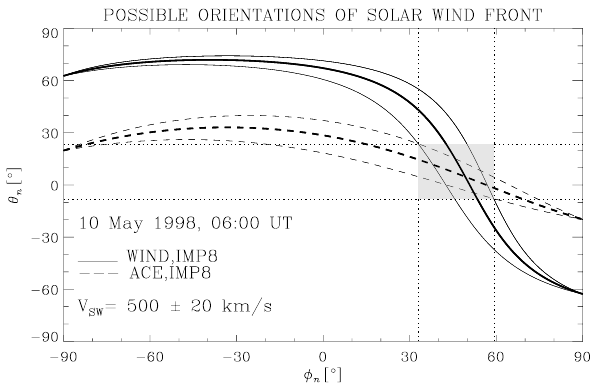
Fig. 4. Possible orientations of solar wind front. Varying ϕ n from − 90 ◦ to + 90 ◦ corresponding angles θ n are computed for two space- craft pairs. The shaded rectangle gives a subrange of values for ϕ n and θ n that satisfy Eq. (2) for a given range of V SW and the observed propagation lags between the